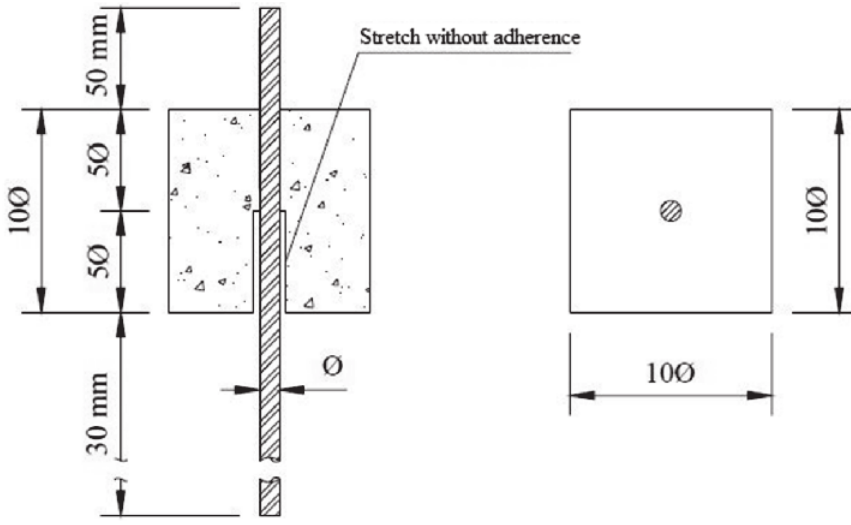
Specimen to the pull-out test indicated by RILEM-FIP-CEB [20] | From: CASTRO [19], p.